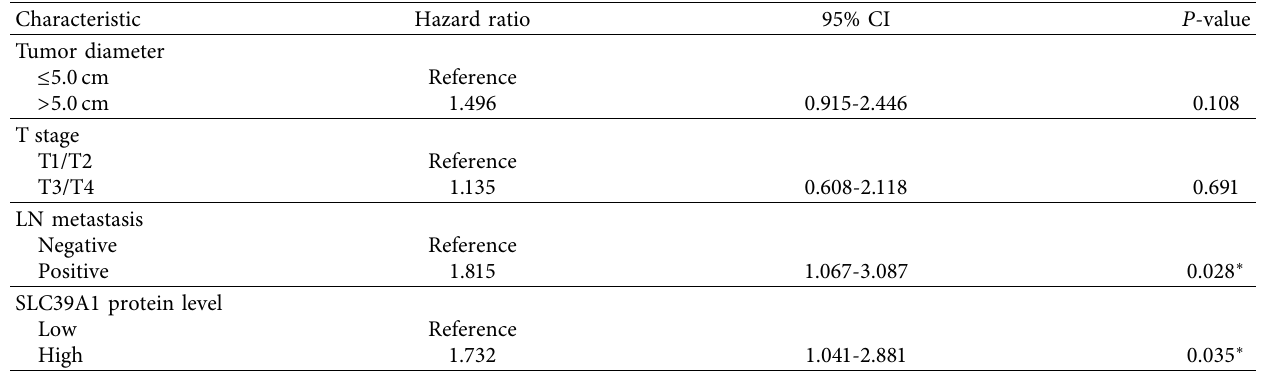
Table 3: Cox hazard regression multivariate